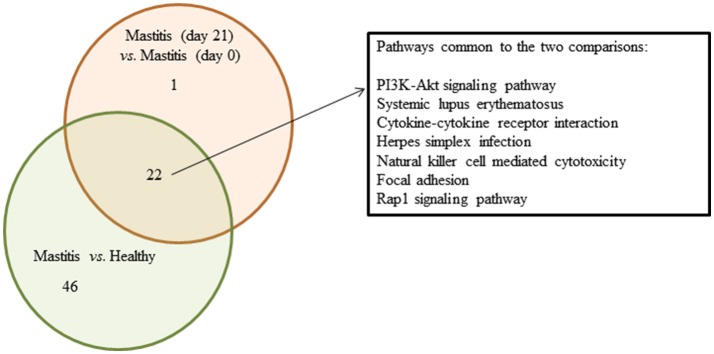
Venn diagram summarizing overlapped pathways related to infection/immune diseases and (or) responses among the DE probes detected in SC of women with mastitis and healthy participants, and women with mastitis before and after the treatment with the probiotic. Green circle shows the number of pathways obtained when comparing samples of women with mastitis and healthy volunteers at day 0; red circle shows the number of pathways obtained when comparing women with mastitis at day 0 and at day 21. Intersection represents the number of overlapped pathways. In the separate square we include the top regulated common pathways.